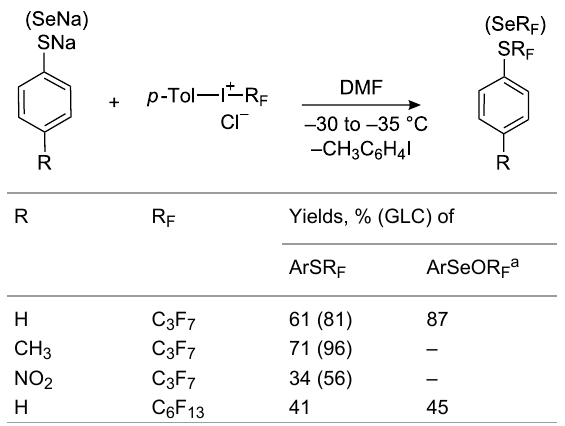
Table 18: Interaction of tolyl perfluoroalkyl iodonium chlorides with sodium thiophenolates and selenophenolate [275].